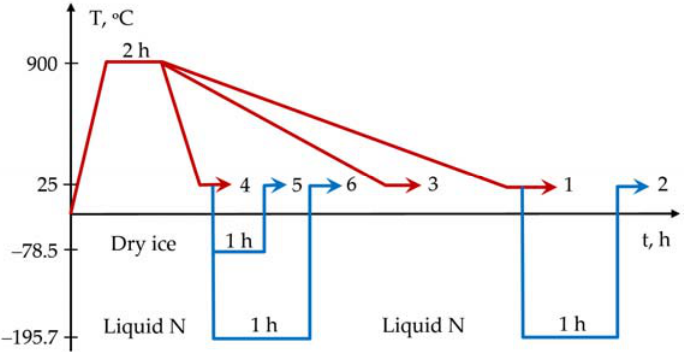
Figure 8. Thermal cycles for TWIP Fe-24 Mn steel. Data from [37].